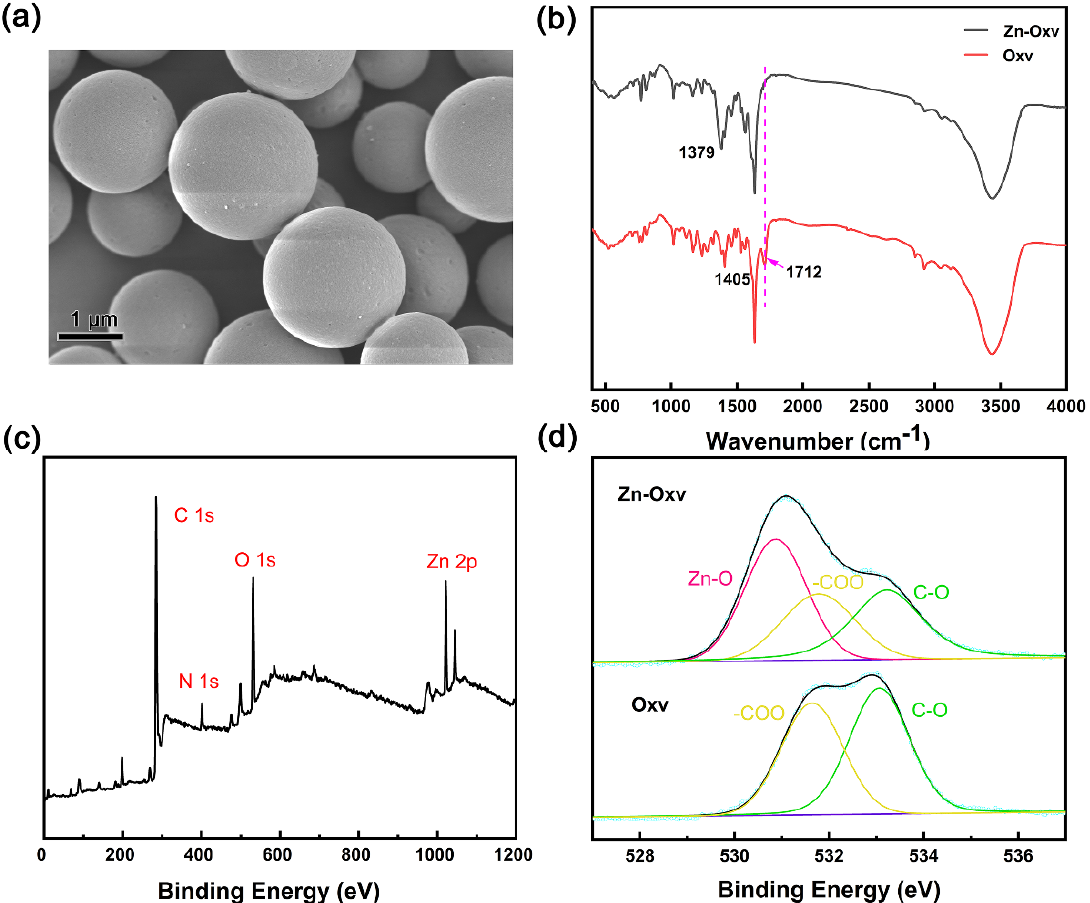
Figure 2. ( a ) The SEM image of Zn − Oxv. ( b ) FTIR spectra of the Zn − Oxv compound and free ligand (Oxv). ( c ) Broad XPS spectrum of the Zn − Oxv compound. ( d ) High − resolution XPS spectra of O 1s for Zn − Oxv.